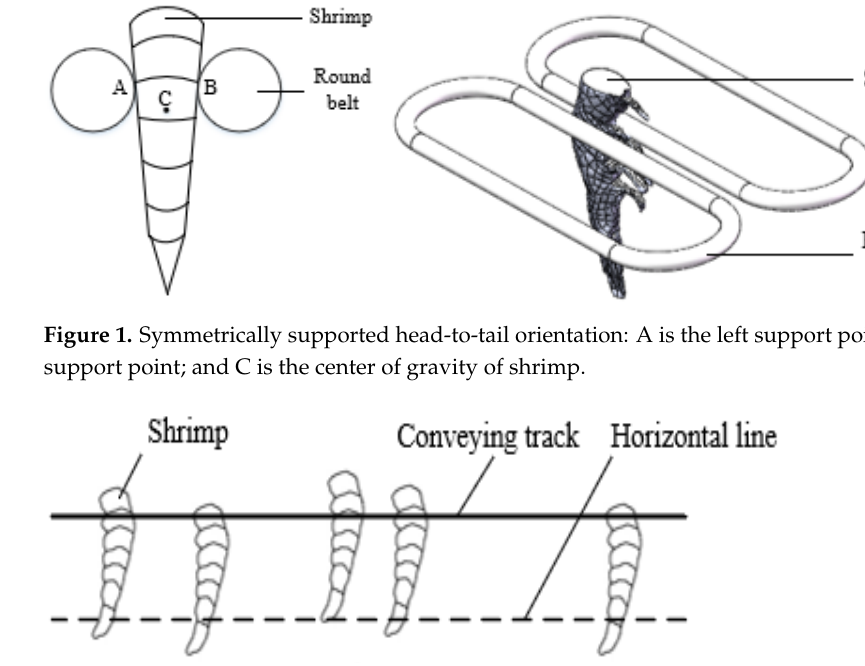
Figure 2. Position of the shrimp after orientation.